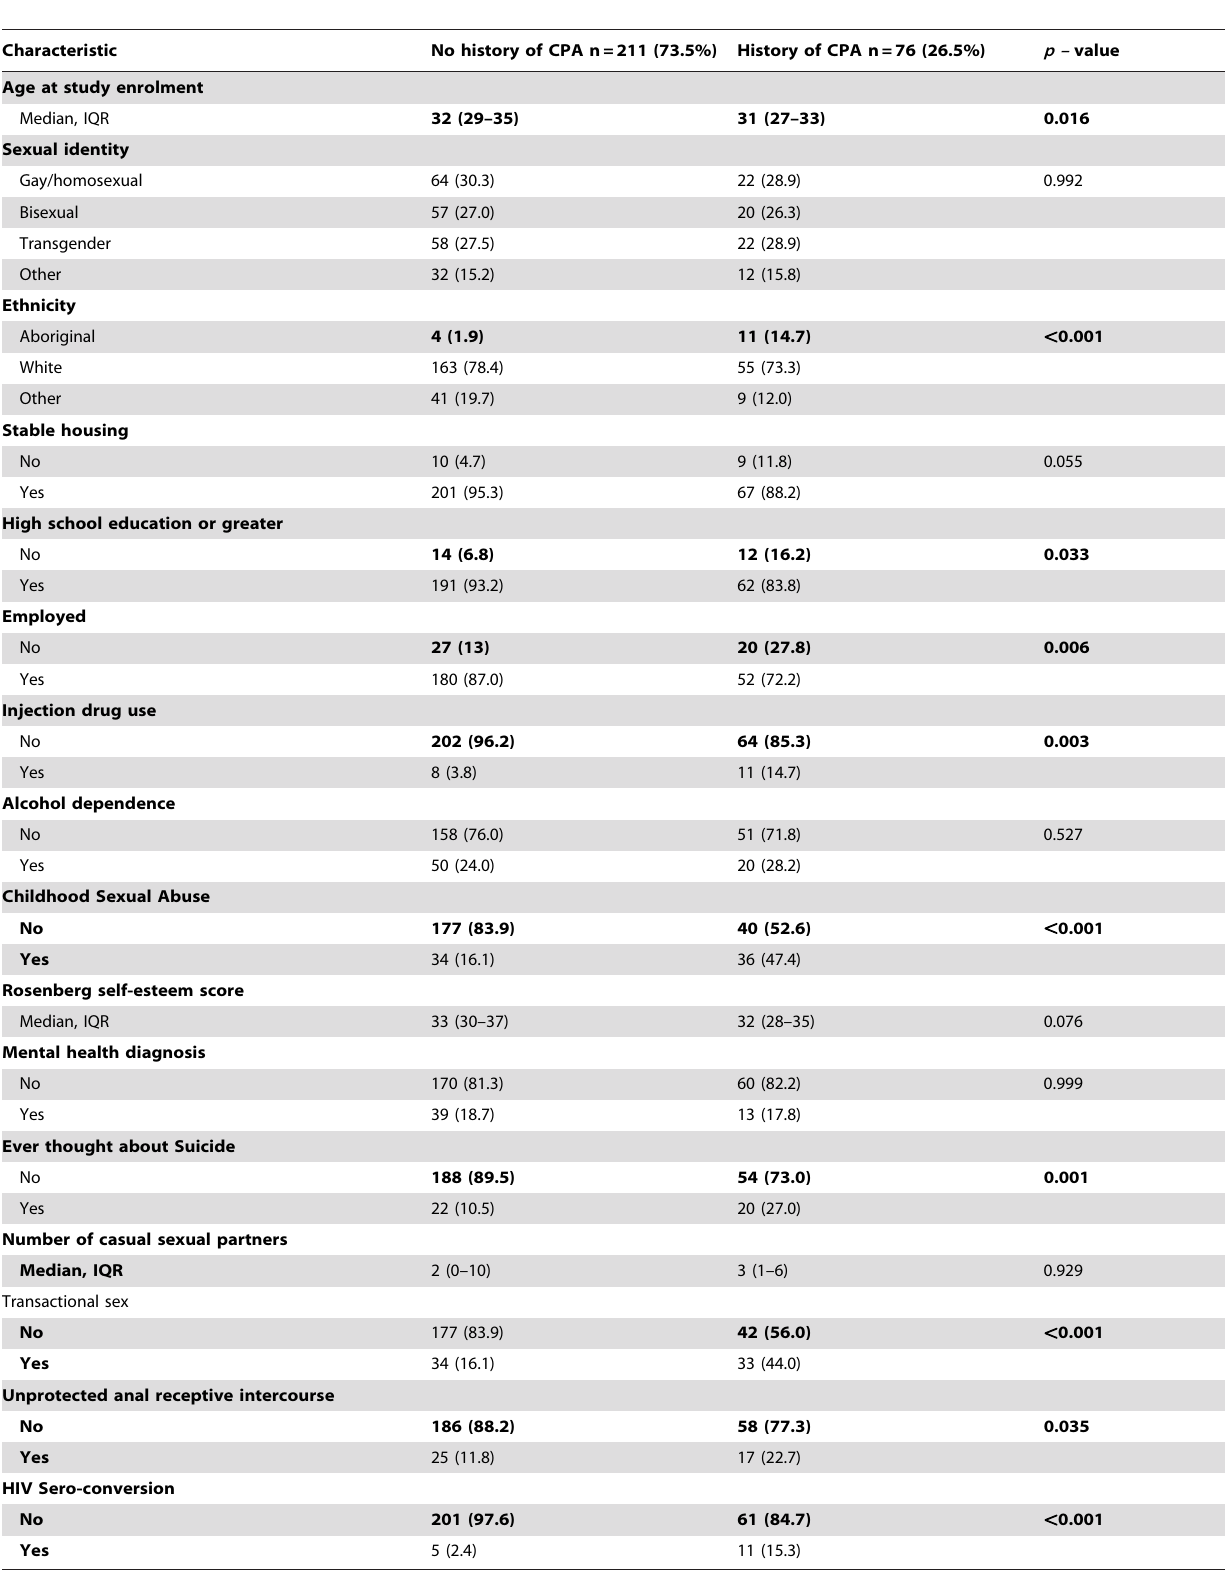
Table 1. Bivariable analysis of factors associated with childhood physical abuse (CPA) among young HIV-negative gay and bisexual men in Vancouver, Canada (n=